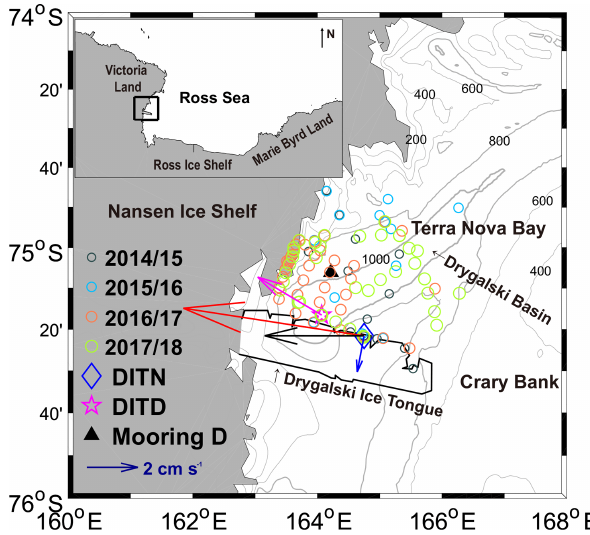
Figure 1. A topographic map of Terra Nova Bay (TNB). The lo- cation of TNB in the Ross Sea is shown in the upper left inset. The bold gray line indicates the 1000m isobaths, and the interval between the thinner gray lines is 200m. Conductivity–temperature– depth (CTD) stations in the austral summers (i.e., 2014, 2015, 2017, and 2018) are denoted by open circles. The averaged current vec- tor from August to November at 660m in the eastern TNB (DITN) (1222m in the Drygalski Basin, DITD) is denoted by a blue (ma- genta) arrow. The red (black) arrow indicates the mean current vec- tor from June to November at 75m (273m) in the DITN. The blue arrow in the bottom left indicates the reference velocity (2cms − 1